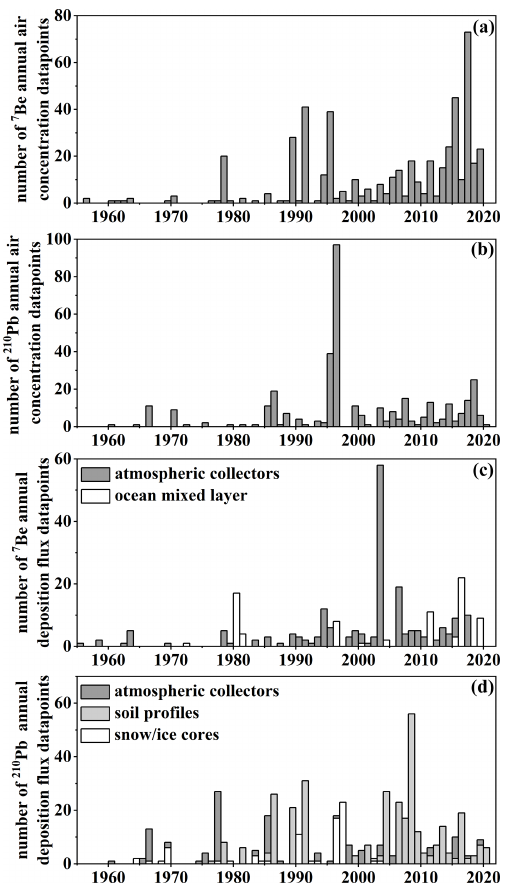
Figure 2. Distributions of data published between 1955 and early 2020: (a) 7 Be concentration, (b) 210 Pb concentration, (c) 7 Be de- positional flux, and (d) 210 Pb depositional flux.